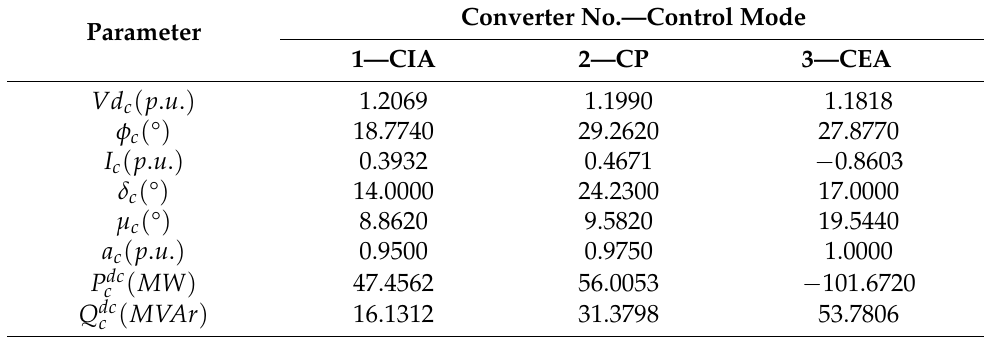
Table 14. HVDC system result for Case 2.